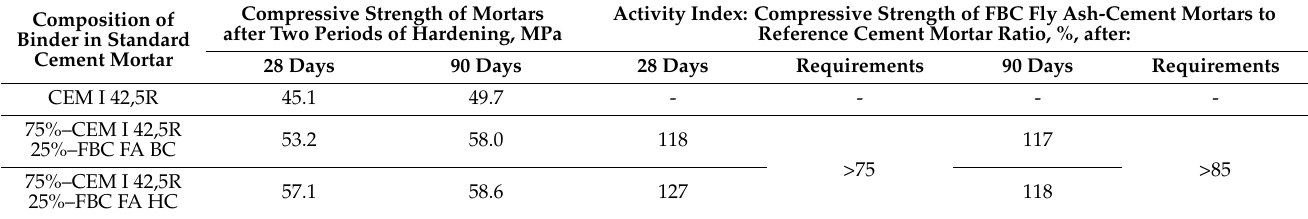
Table 4. Pozzolanic activity of both types of fly ash according to EN